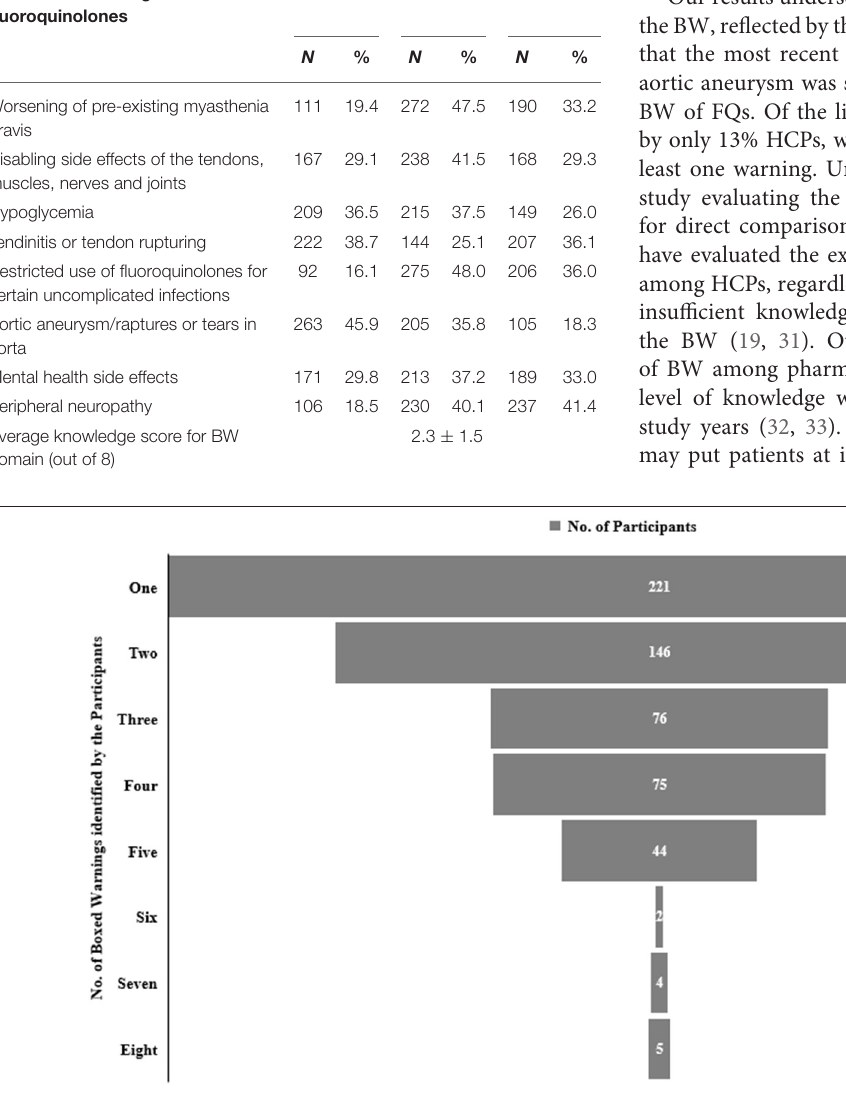
FIGURE 2 | The frequency distribution on the selection of boxed warnings (BWs) against FQs among study participants.